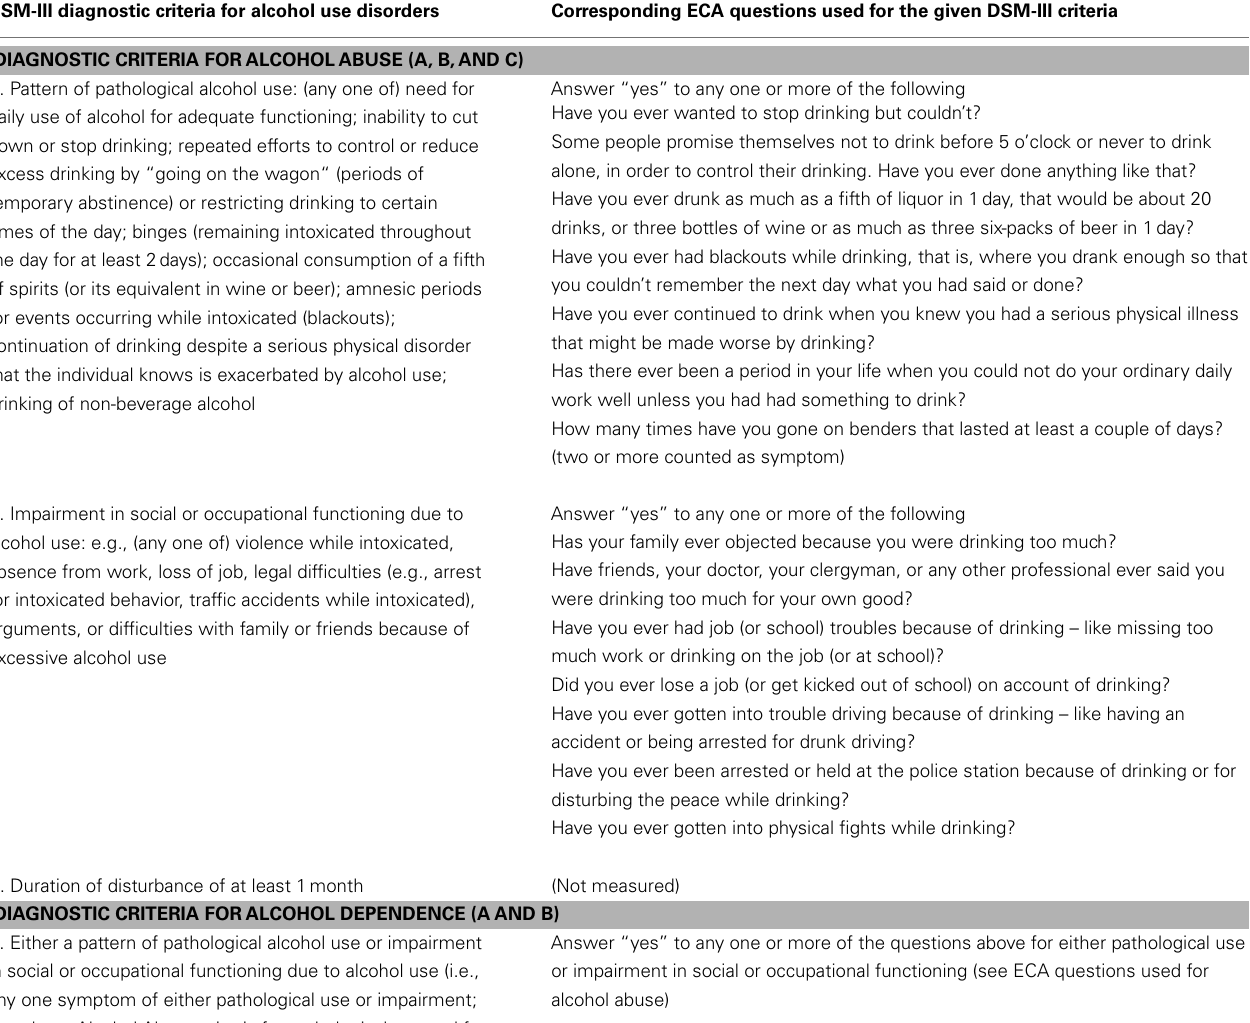
TableA1 | DSM-III diagnostic criteria for alcohol use disorders and their translation using epidemiologic catchment area study (ECA) questions . DSM-III diagnostic criteria for alcohol use disorders Corresponding ECA questions used for the given DSM-III